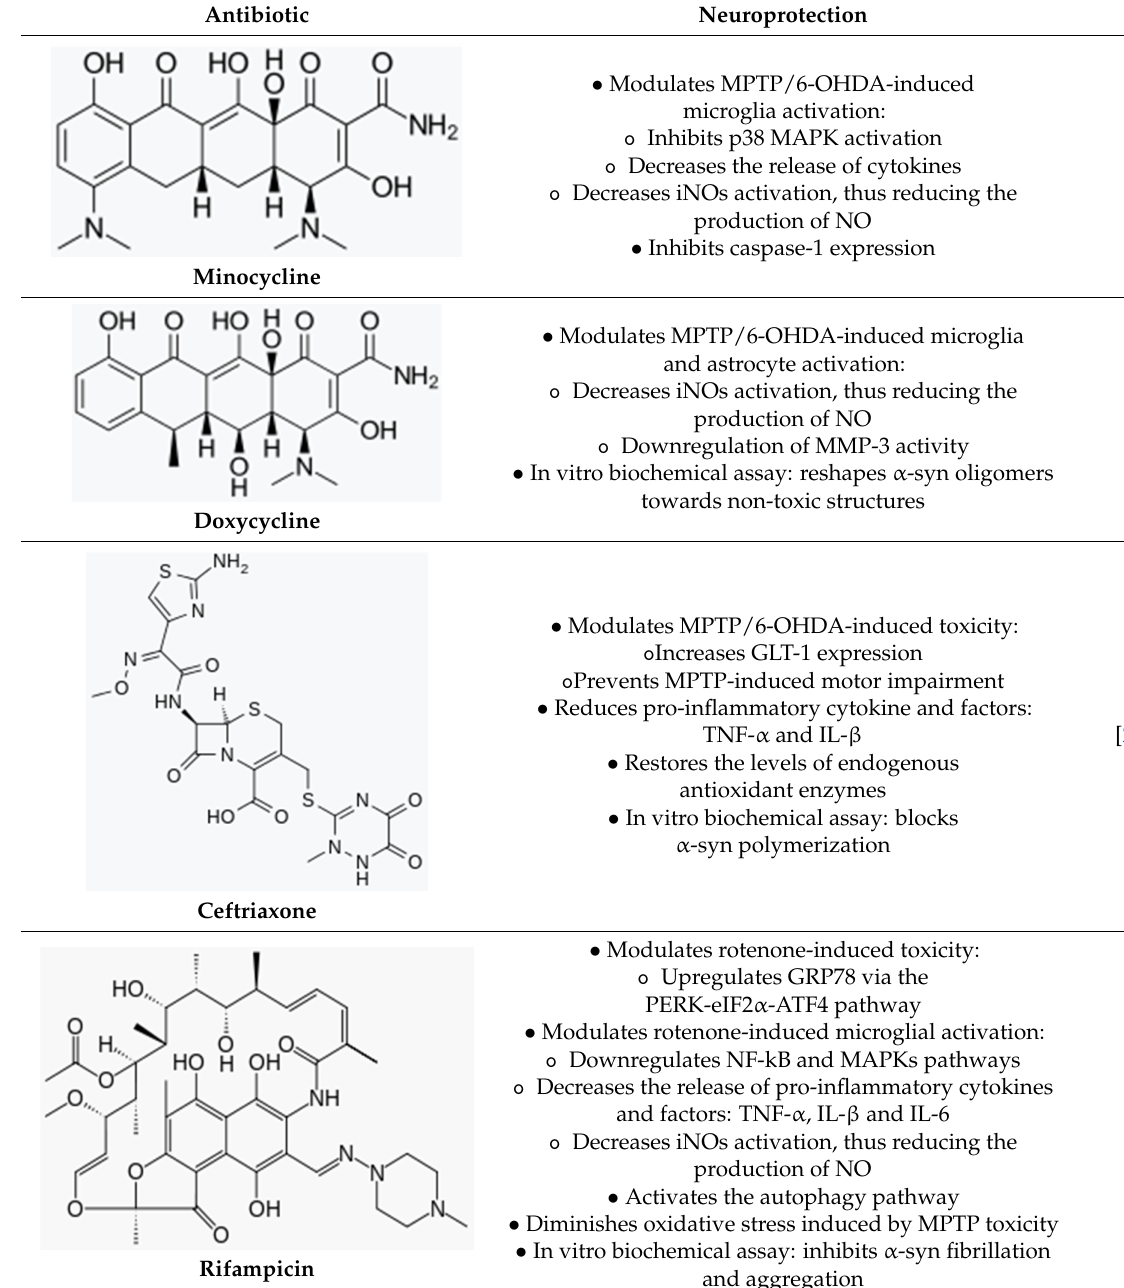
Table 2. Neuroprotective effects of antibiotics in different experimental PD models.